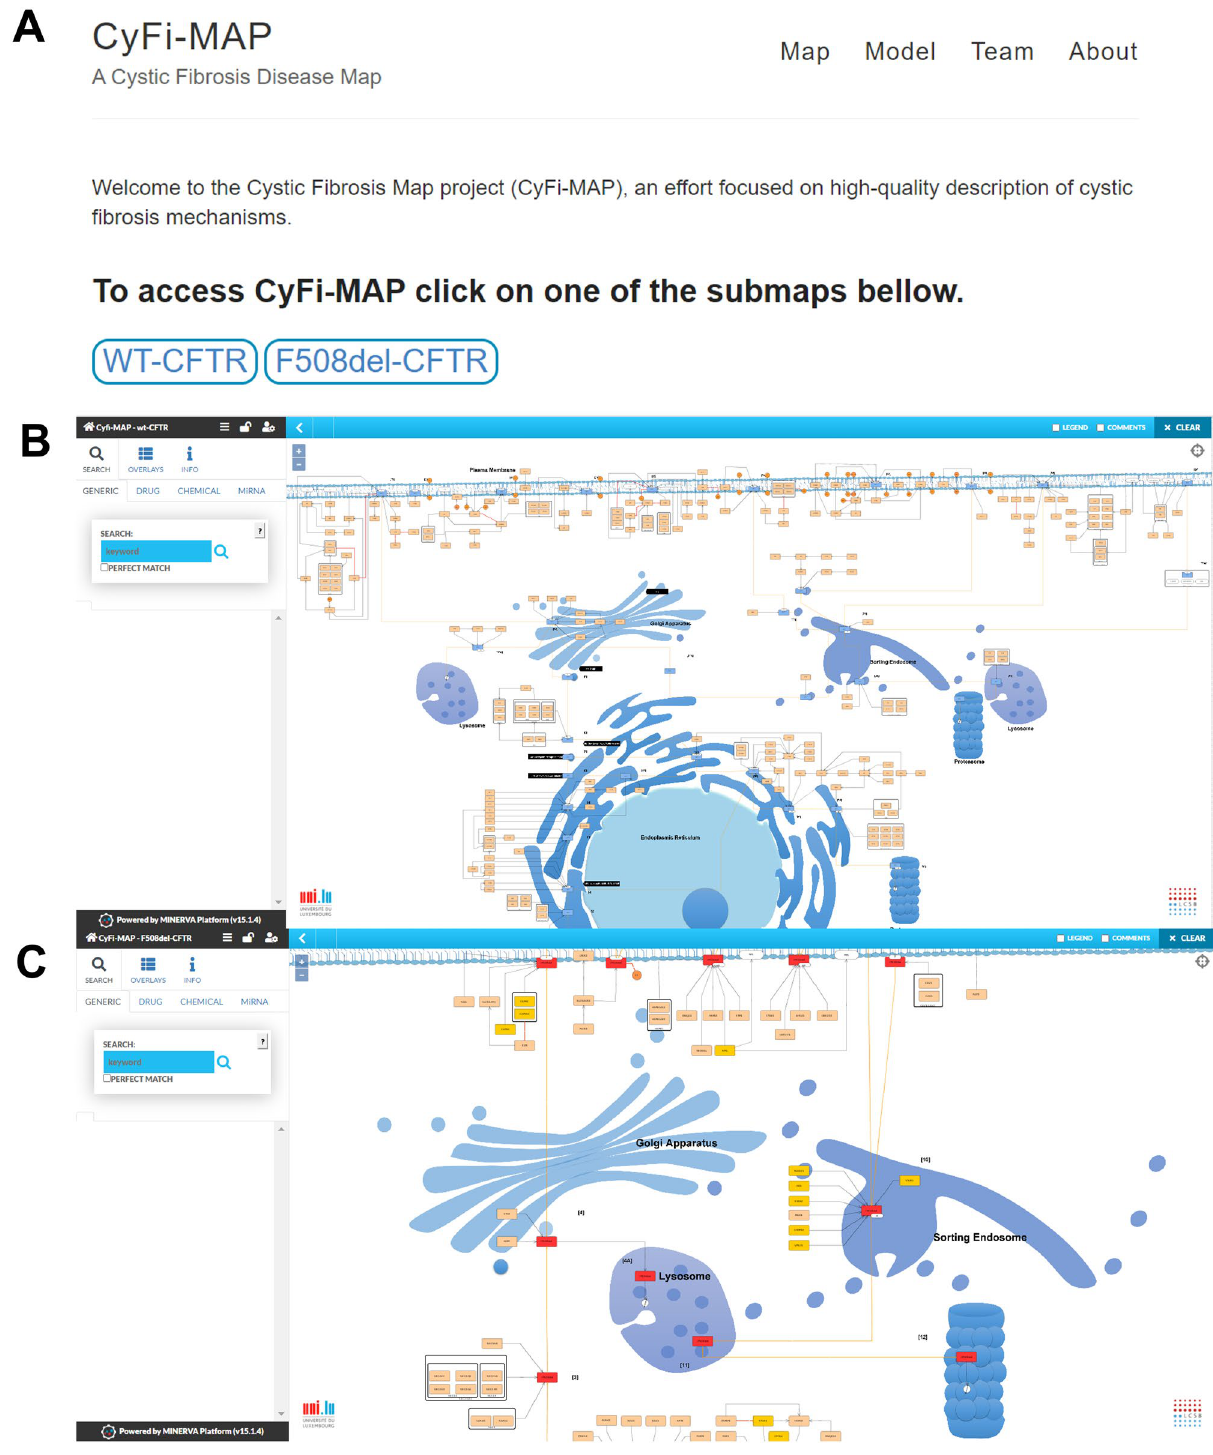
Figure 2. CyFi-MAP Github and MINERVA platform. In the image ( A ) is possible to see the GitHub page with the objective to contextualize this work and provide access to the interactive MINERVA platform. In image ( B ) and ( C ) are represented both submaps, wt- CFTR and F508del- CFTR respectively, where it is possible to navigate and explore the pathways and interactions included in CyFi-MAP, providing generic information about the proteins and